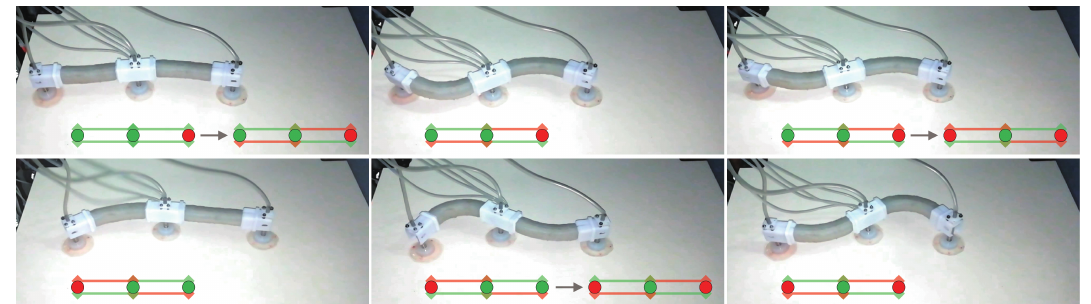
Figure 12. 2D-Dancer’s in-plane locomotion. Forward movement with snake-like crawling locomotion (A red circle represents a fixed sucker, and a green one represents a relaxed sucker. A red line represents an inflated cavity, and a green one represents a deflated